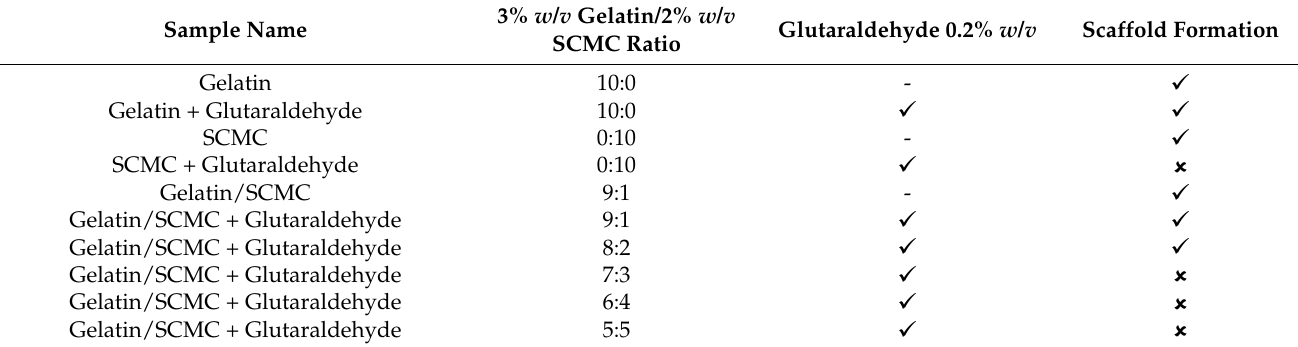
Table 1. Formation of scaffold prepared from gelatin, sodium carboxymethyl cellulose, and gelatin/SCMC mixture.